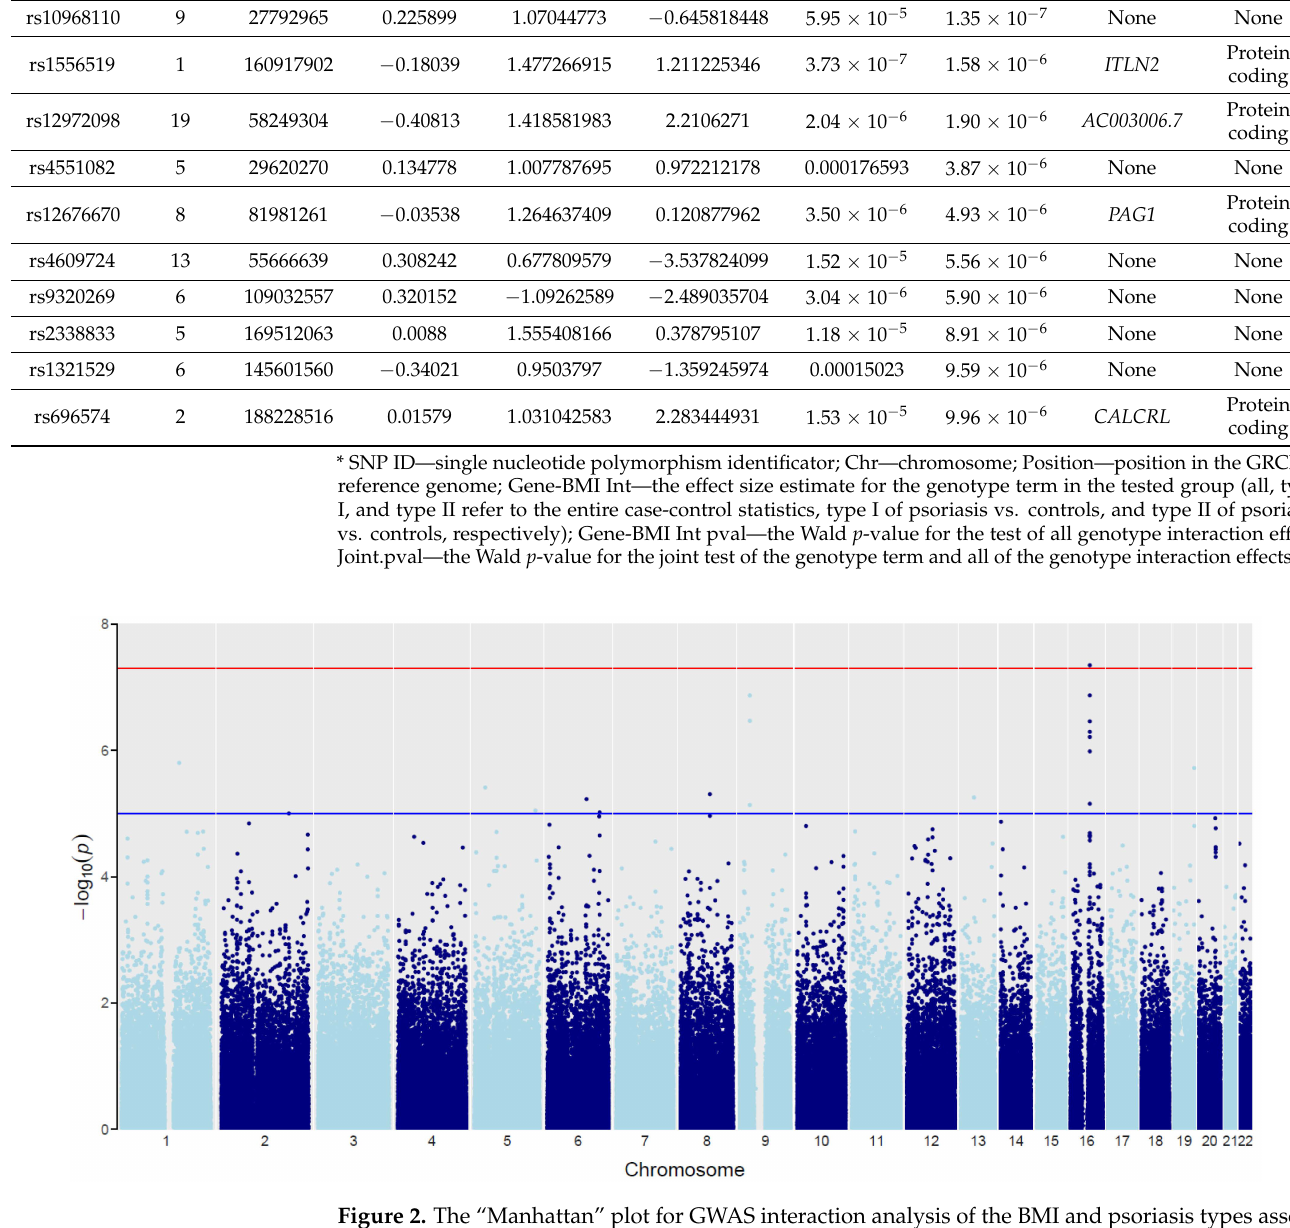
Figure 2. The “Manhattan” plot for GWAS interaction analysis of the BMI and psoriasis types associ- ation. Chromosomes are represented on the x -axis (black and grey dots). The − log 10 (Joint.pval) is represented on the y -axis. Blue line indicates a suggestive association threshold (Joint.pval = 1 × 10 − 5 ). Red line indicates the genome-wide significant threshold (Joint.pval = 5 × 10 − 8